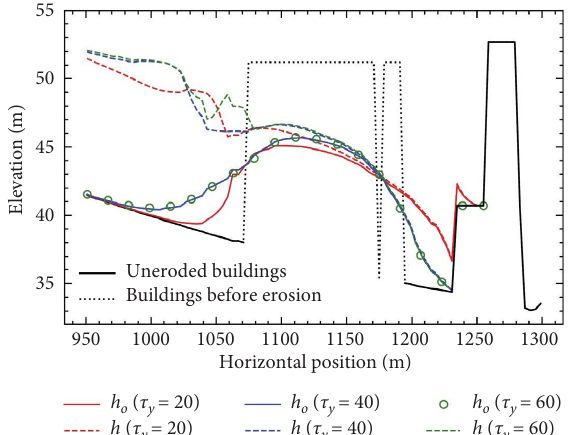
Figure 12: Comparison of the fnal depositional characteristics with diferent yield